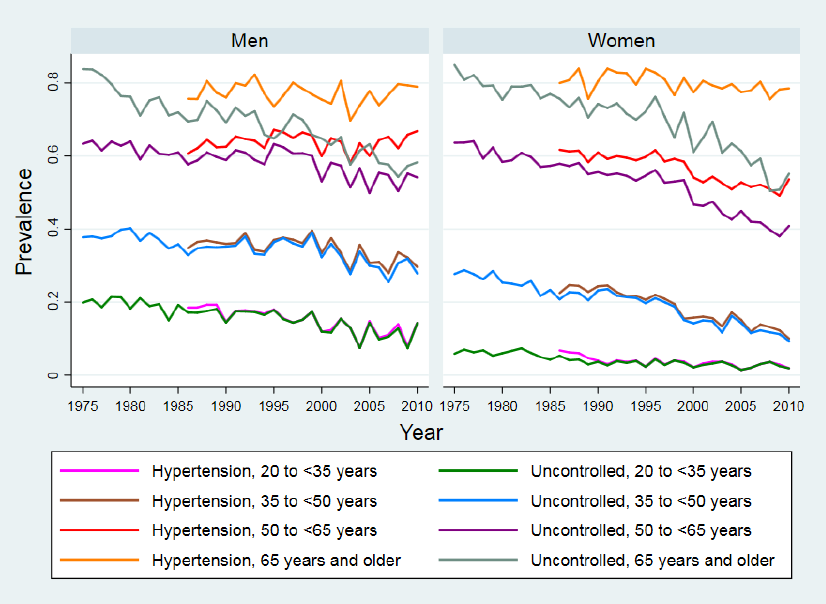
Figure 1. The prevalence of hypertension (1986–2010) and the proportion of individuals with uncontrolled hypertension (1975–2010) in Japan by sex and age.